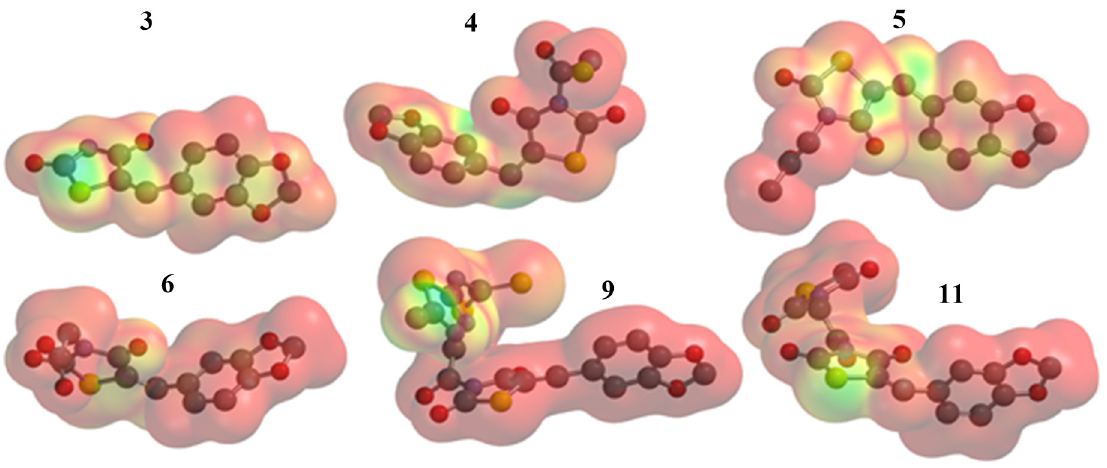
Figure 3. Plotted MEP of synthesized compounds (3–6, 9, and